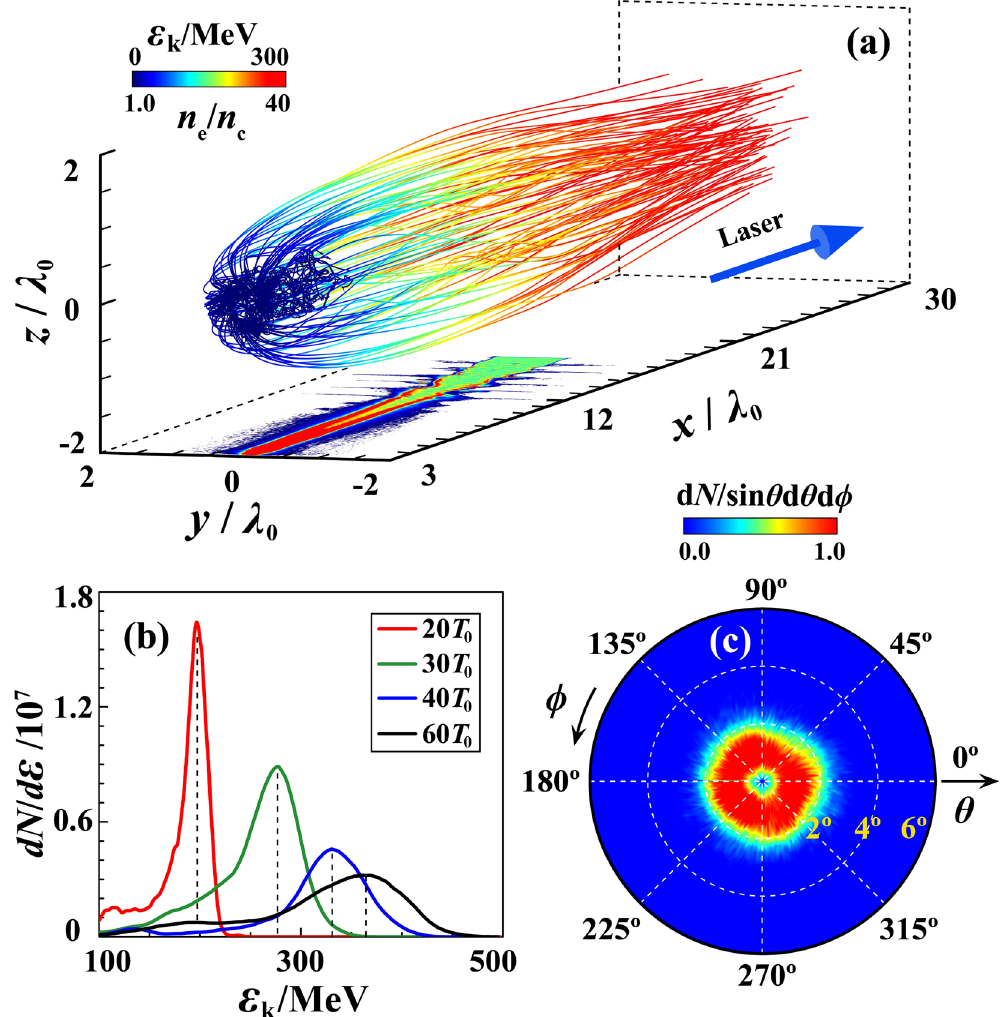
Figure 3. Trajectories of some energetic electrons until t = 35 T 0 ( a ), the energy spectrum of the bunch ( b ) as marked in Fig. 1, and the electron emission angle at t = 60 T 0 ( c ). Here, θ = arctan ( p ⊥ / p x ), φ = arctan ( z / y ), and 2 2 1/2 . The bottom panel in ( a ) shows the electron density distribution in the xy plane at t = 20 T = + p p p ( ) ⊥ y z